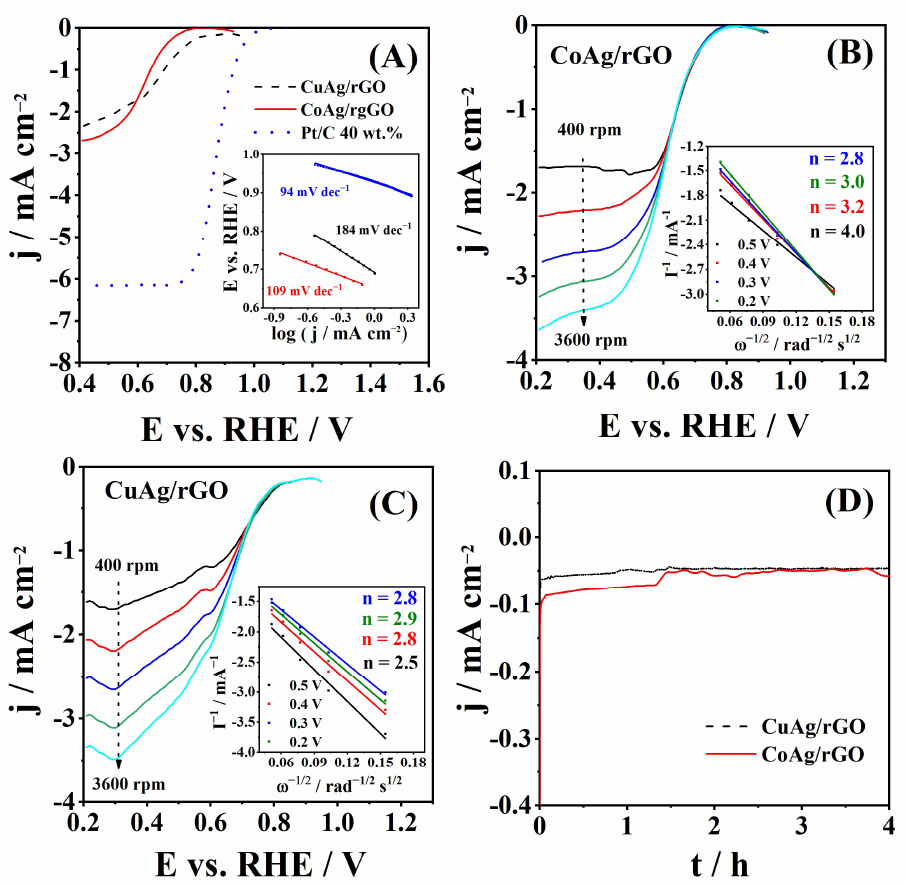
Figure 6. ORR polarization curves measured at 20 mV s − 1 and 1600 rpm with the corresponding Tafel plots shown in the inset ( A ), ORR polarization curves of CoAg/rGO ( B ) and CuAg/rGO ( C ) electrocatalysts at different rotation rates with Koutecky-Levich analysis in the inset, and the chronoamperometric curves ( D ) recorded in O 2 -saturated 0.1 M KOH solution. Furthermore, a higher diffusion current density, j d , was obtained for CoAg/rGO (−2.63 mA cm −2 ) than for the CuAg/rGO (−1.74 mA cm −2 ) electrocatalyst. Ag/C gave a j d of ca. −1.8 mA cm −2 than herein tested silver electrocatalysts in alkaline media [70]. A j d of